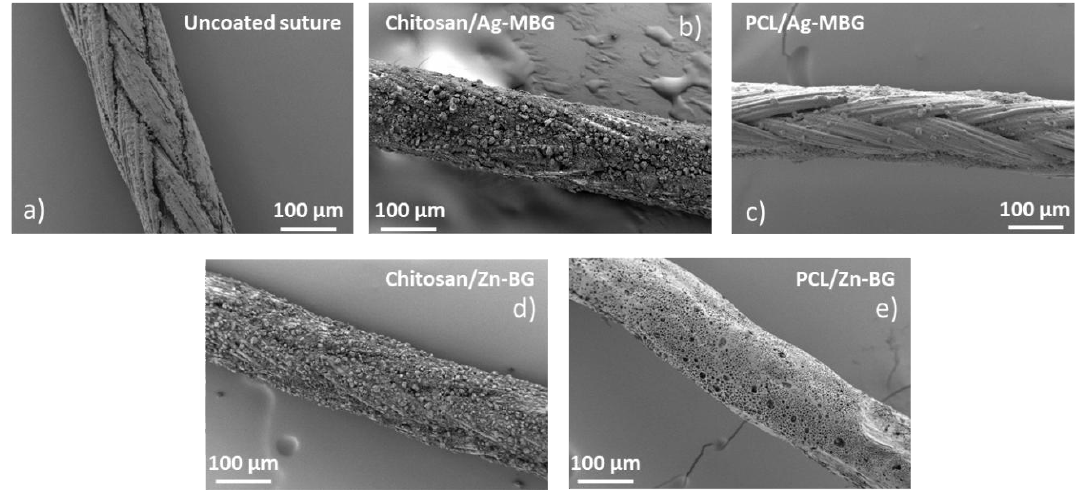
Figure 1. SEM micrographs showing the morphology of: ( a ) Uncoated Vicryl ® Plus suture, ( b ) chitosan/Ag-MBG-coated suture, ( c ) PCL/Ag-MBG-coated suture, ( d ) Chitosan/Zn-BG-coated suture, and ( e ) PCL/Zn-BG-coated suture.